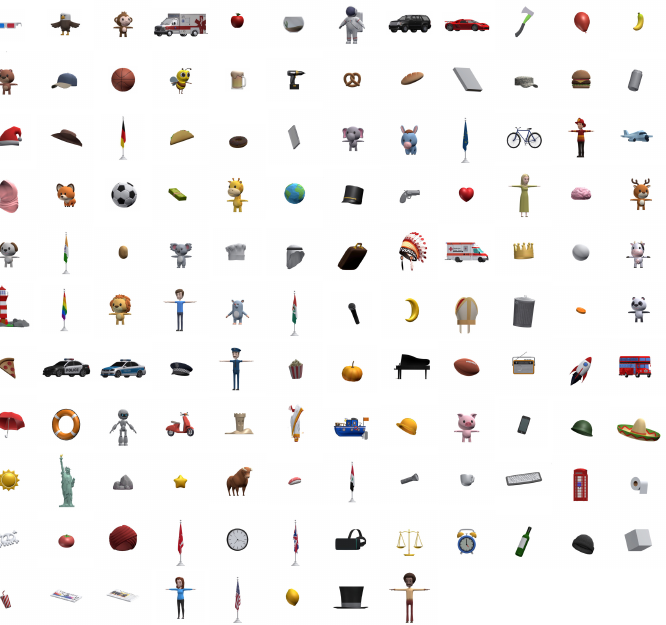
Figure A3. The figure shows the virtual objects identified and evaluated for the first proposal of the InteractionSuitcase